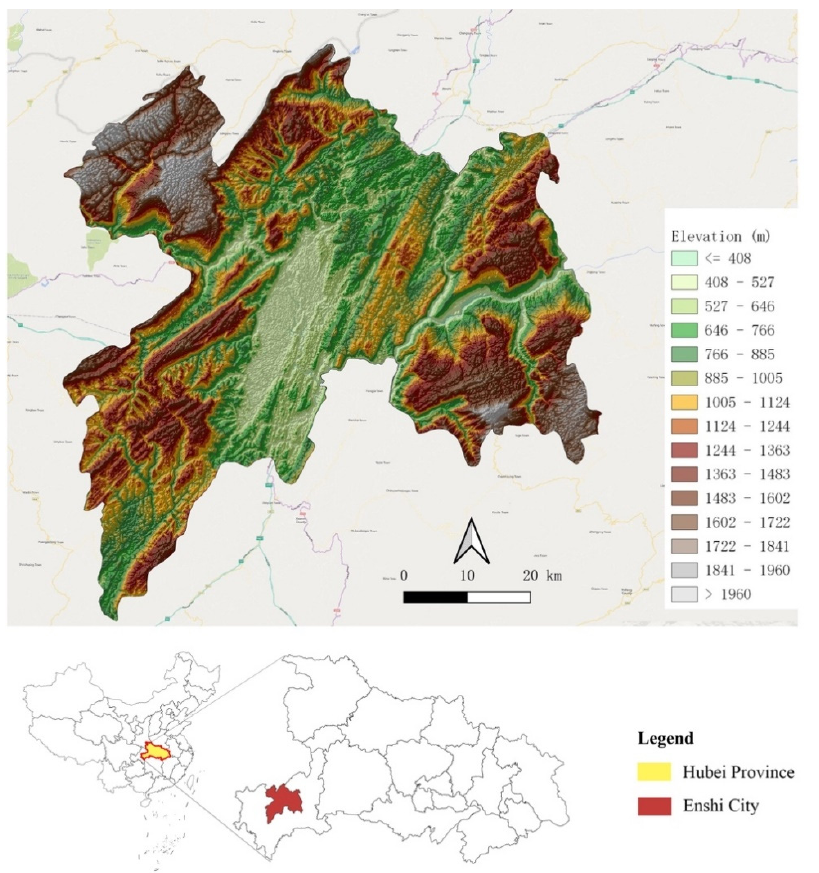
Figure 1. Location and elevation of Enshi City. Elevation data was obtained from the ASTER global digital elevation model [35].